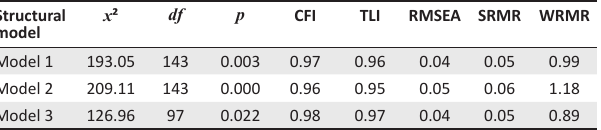
TABLE 4: Goodness-of-fit indices of structural models.